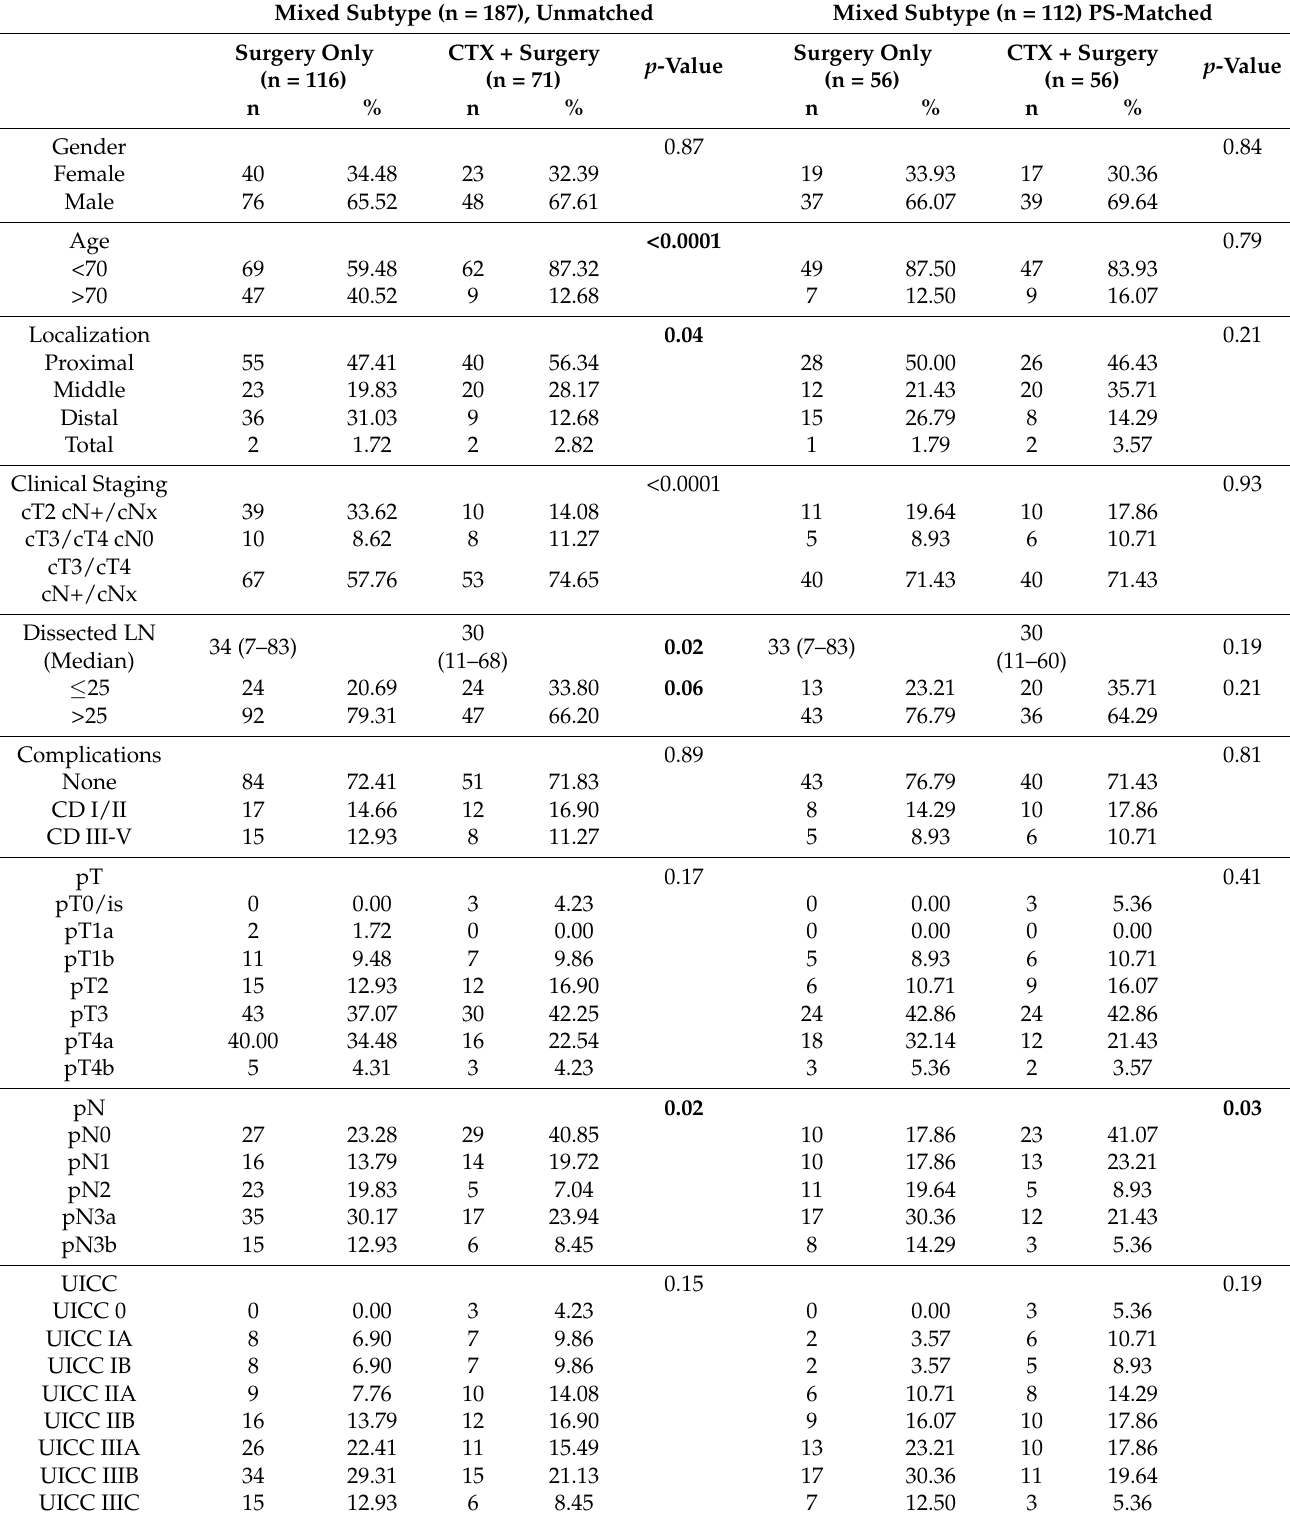
Table 3. Baseline characteristics for patients with mixed Lauren subtype before and after PSM. Mixed Subtype (n = 187),